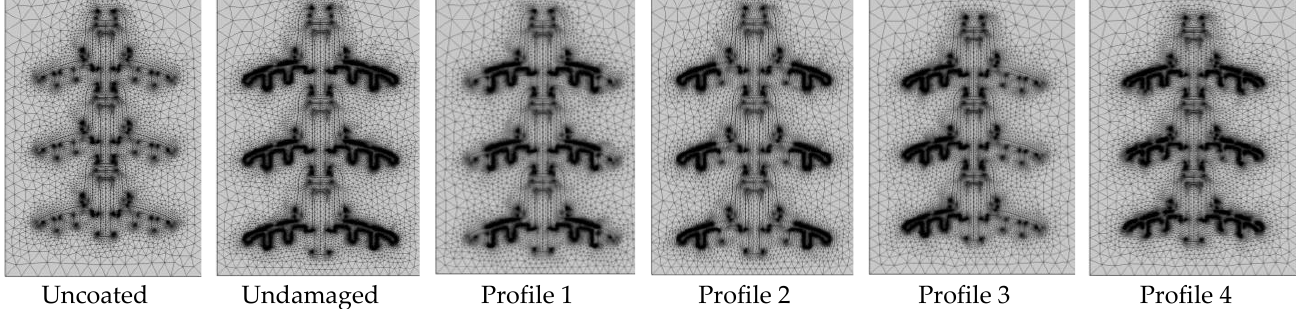
Figure 11. FEM mesh for all profiles.